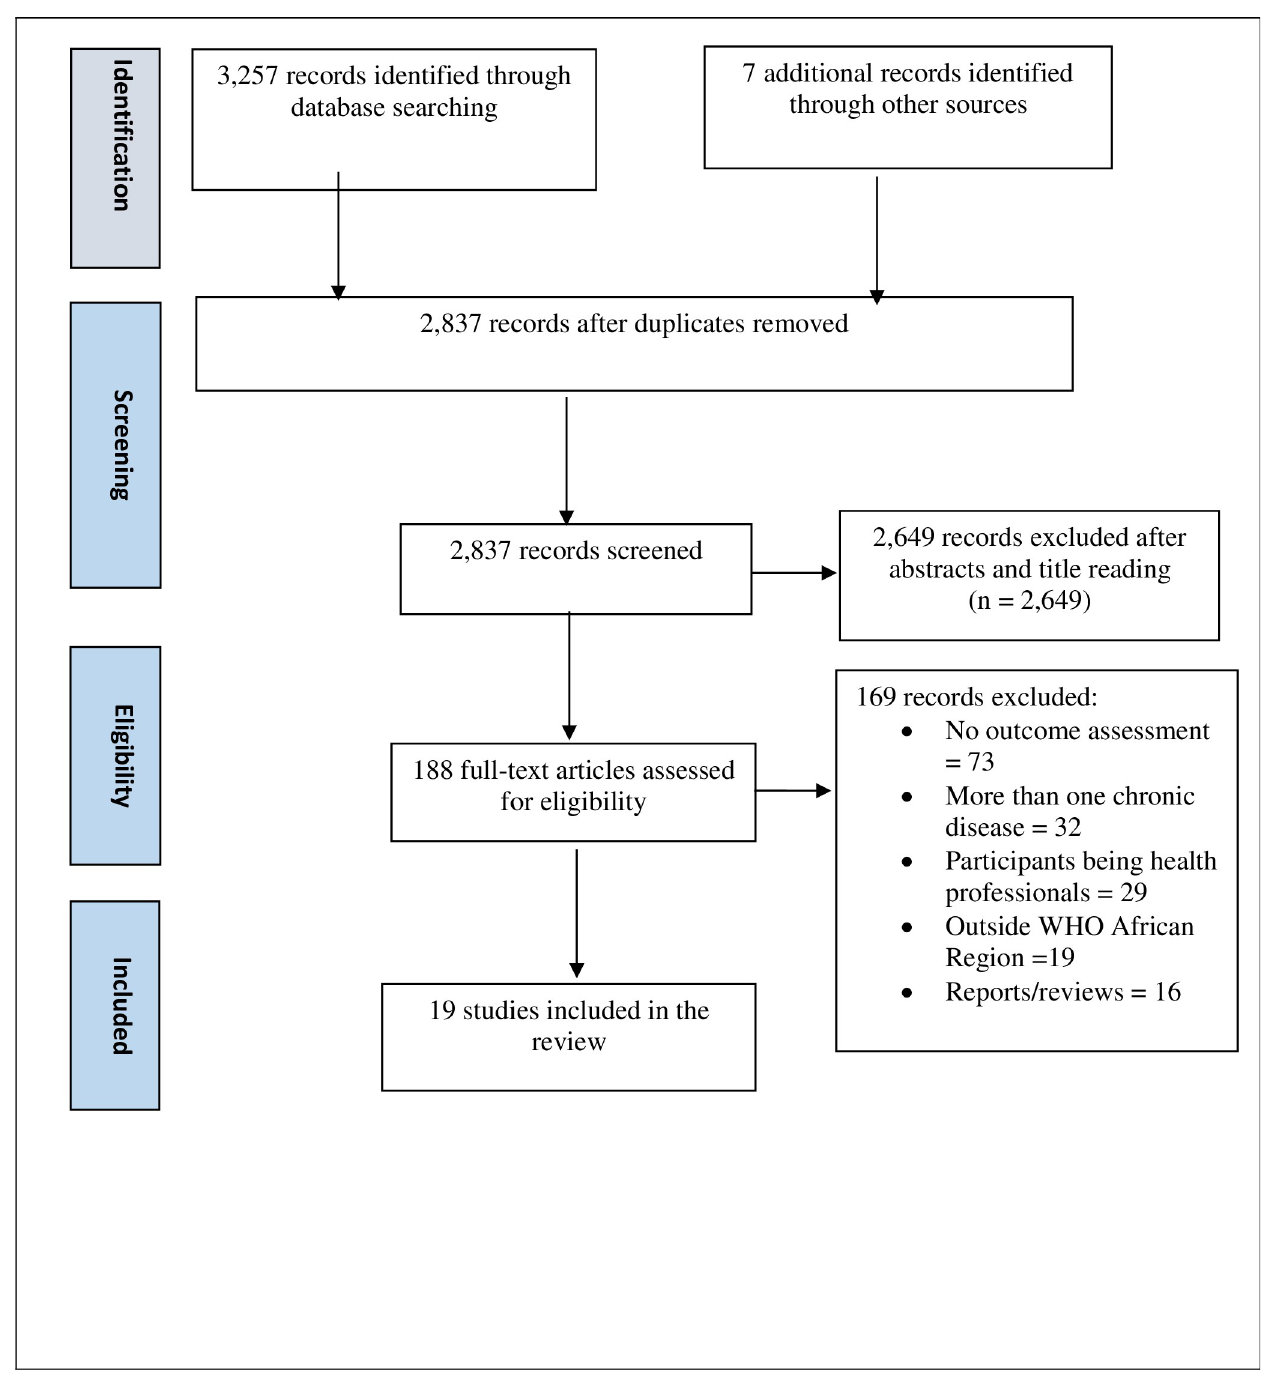
Fig 1. Literature search flow